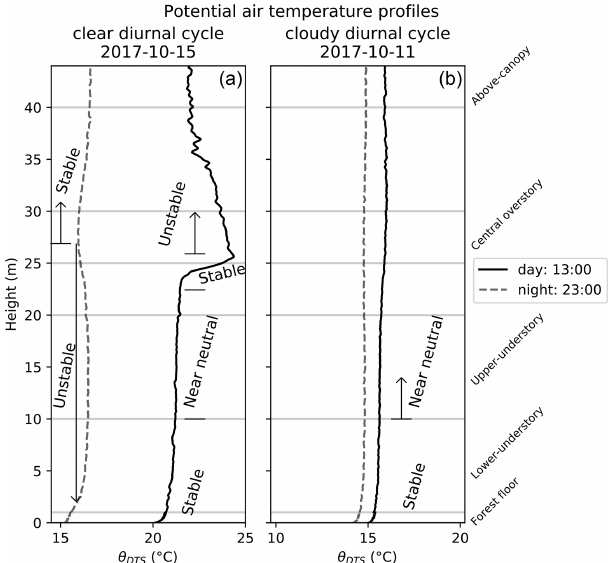
Figure 4. Example of potential air temperature ( θ(z) ) profiles to illustrate the DTS measurements (15min average temperature). On 15 October 2017 (a) the day was sunny and the night was clear. On 11 October 2017 (b) the day and night were cloudy. Times are in UTC+1.